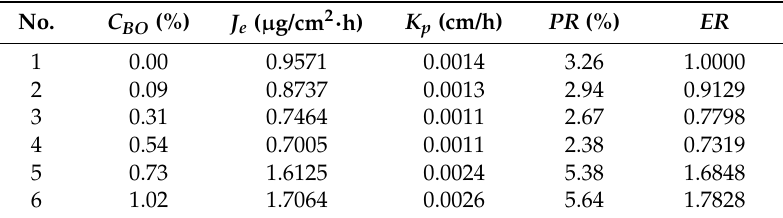
Figure 8. Cumulative amount of osthole in the presence of varying concentration of borneol and the corresponding zero-order kinetics equations. Table 1. Assessment parameters calculated from Q n -t equations.